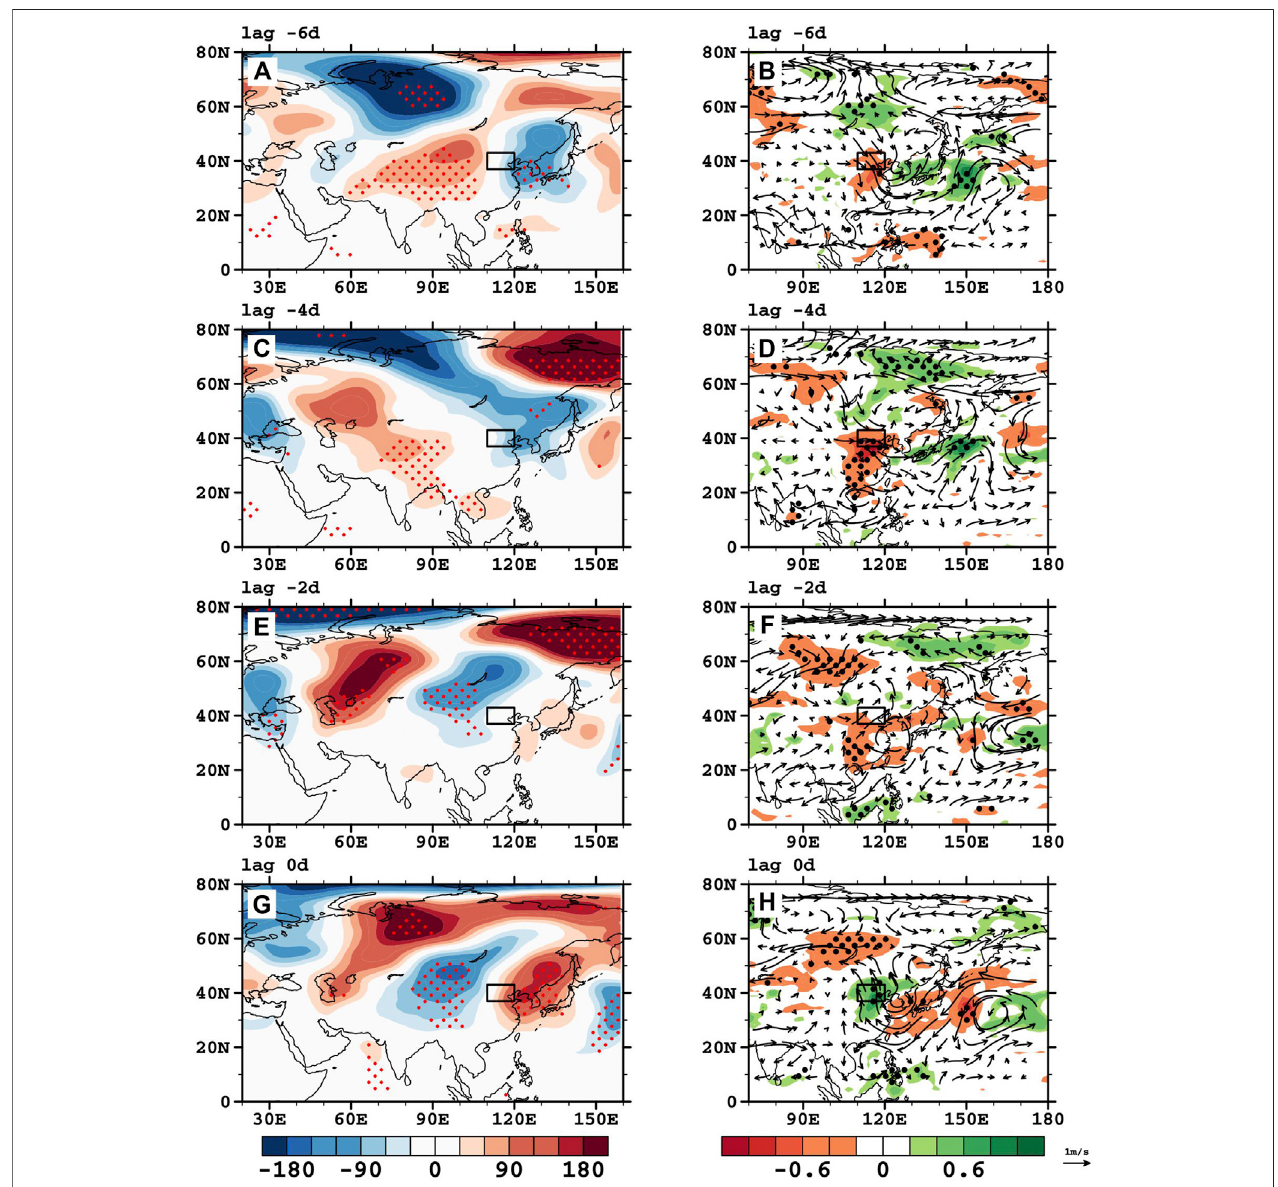
FIGURE 9 | 10 – 20-day fi ltered geopotential height (shading, unit: gpm) fi elds at 500 hPa (A,C,E, G) and speci fi c humidity (shading, unit: g · kg − 1 ) and wind (vector, unit: m · s − 1 ) fi elds at 850 hPa (B,D,F,H) during day 6, 4, 2, and 0 prior to the onset of type 1 PEPEs. Red and black dotted areas indicate a 95% con fi dence level. The rectangle indicates North